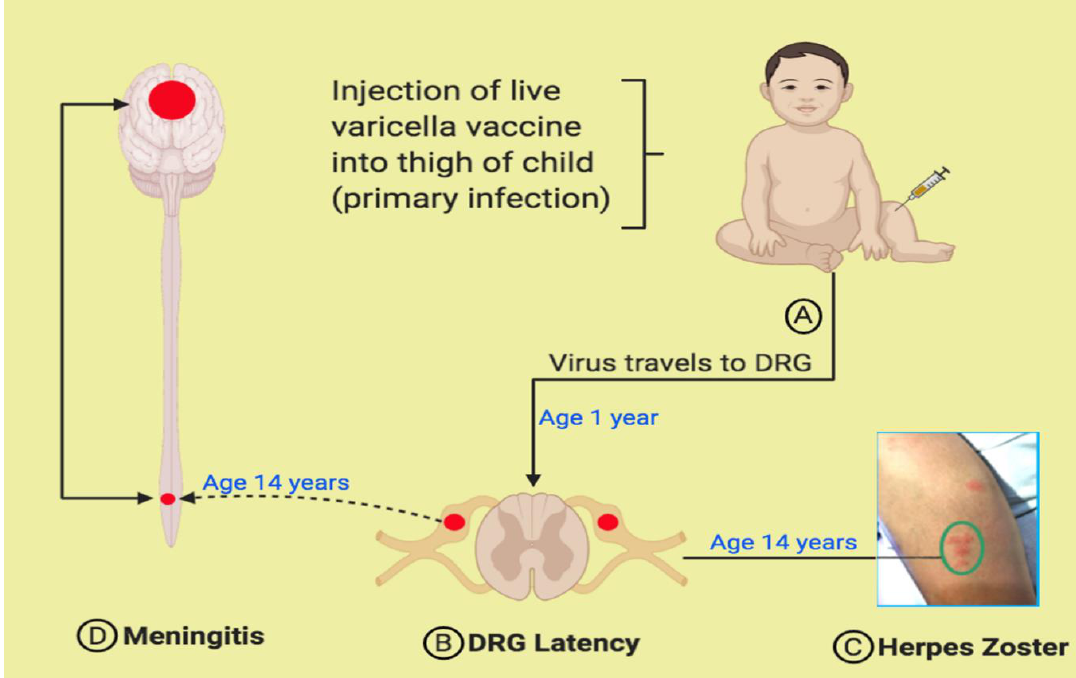
Figure 4. Pathogenesis of varicella meningitis in an immunized child. After a varicella vaccination, the virus is transported via sensory nerves from the skin ( A ) to the lumbar dorsal root ganglion (DRG) ( B ). When the virus reactivates from the DRG, the virus is carried to the lumbar dermatome in the thigh ( C ). The rash in Panel C is the herpes zoster rash of case #4 in Table 2. The virus is also carried into the spinal cord, where meningitis ensues ( D